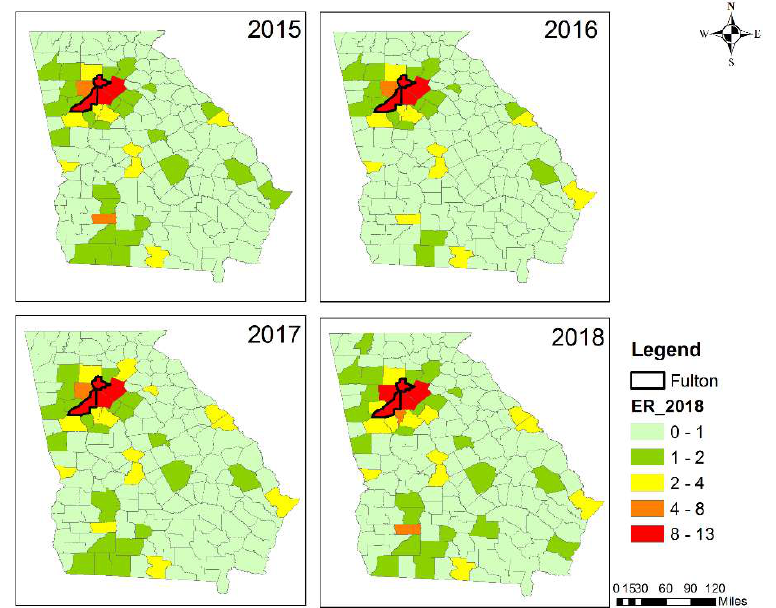
Figure 8. Estimated asthma-related ER visits by the county in Georgia from 2015 to 2018 for the first four months of the year.